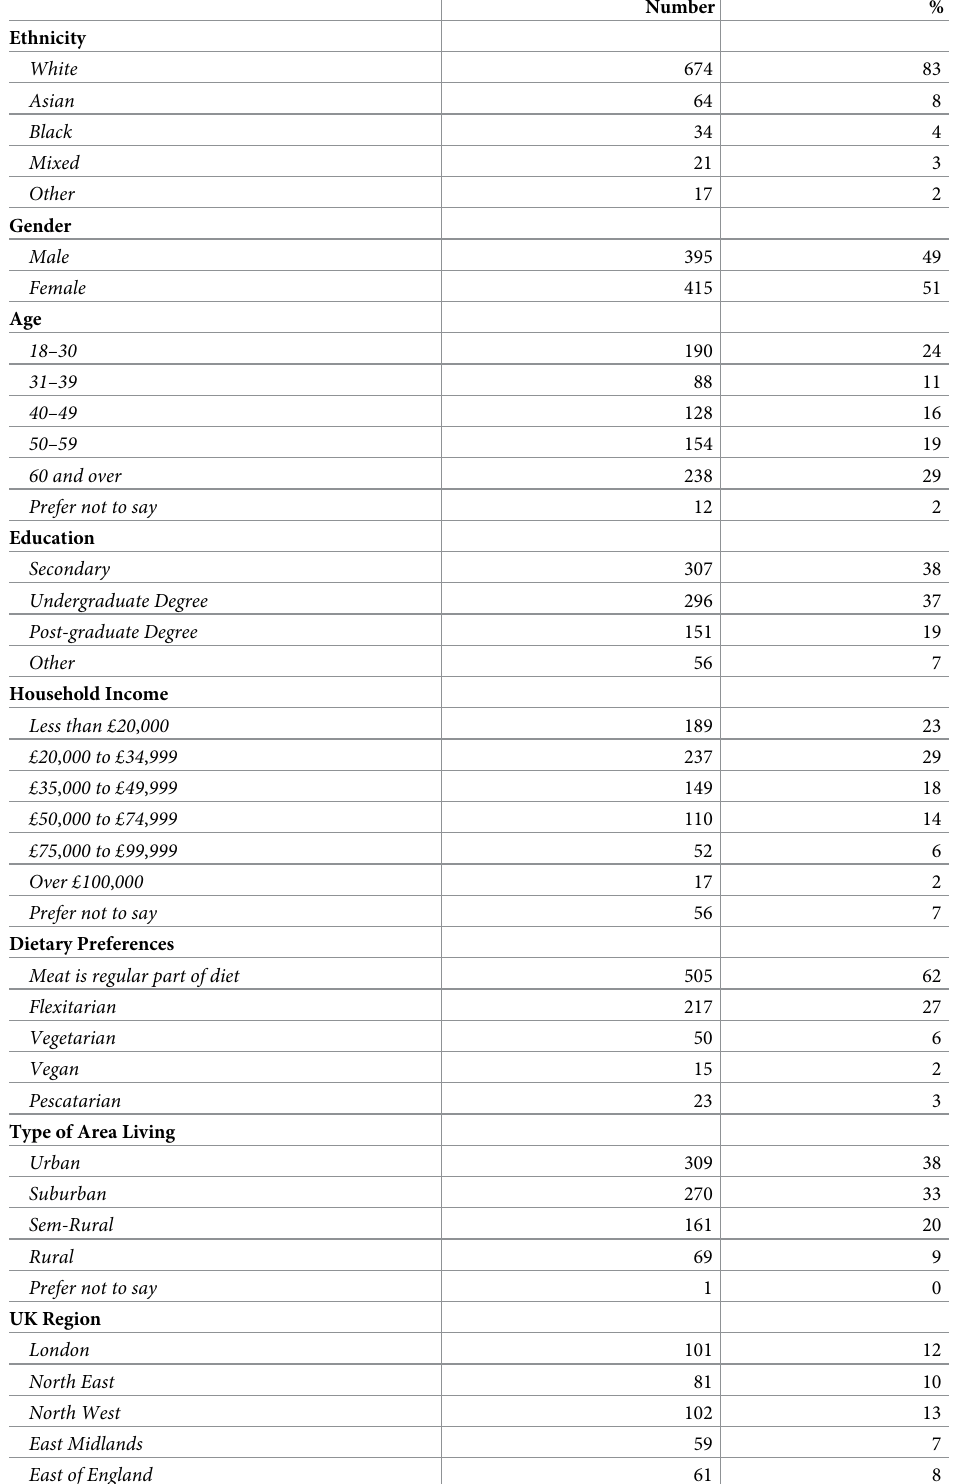
Table 2. Demographic data of study